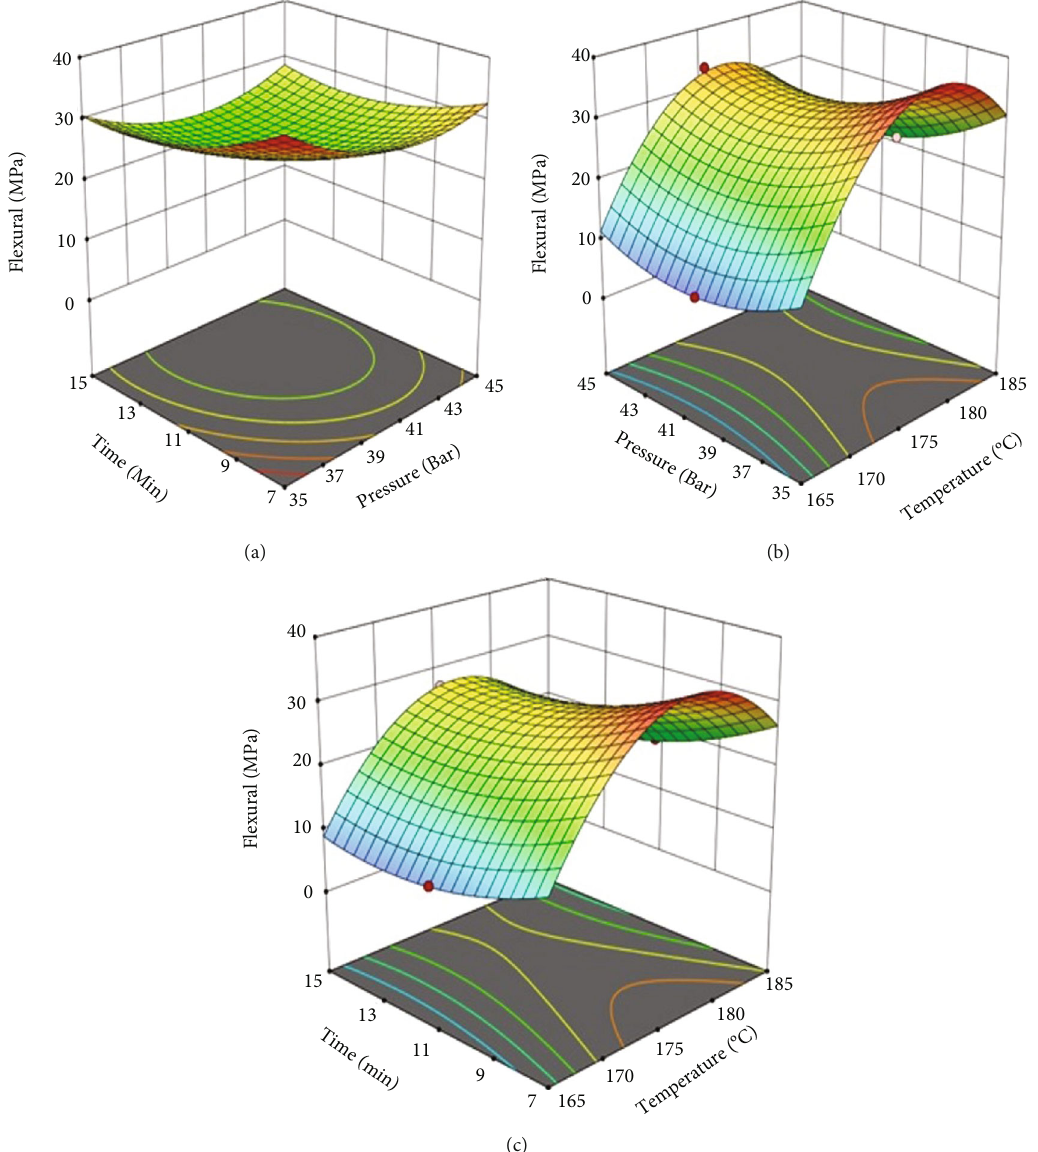
Figure 6: Flexural behavior of (a) pressure vs. time; (b) temperature vs. pressure; (c) temperature vs. time of CGF- and hemp-based hybrid